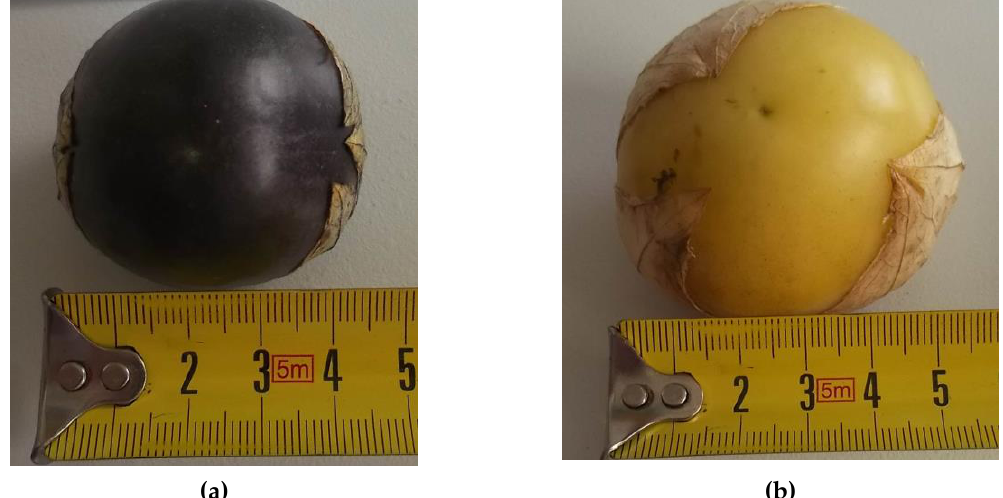
Figure 2. The ripe fruits of the studied husk tomato cultivars: Plum Jam ( a ) and Confectioner ( b ).